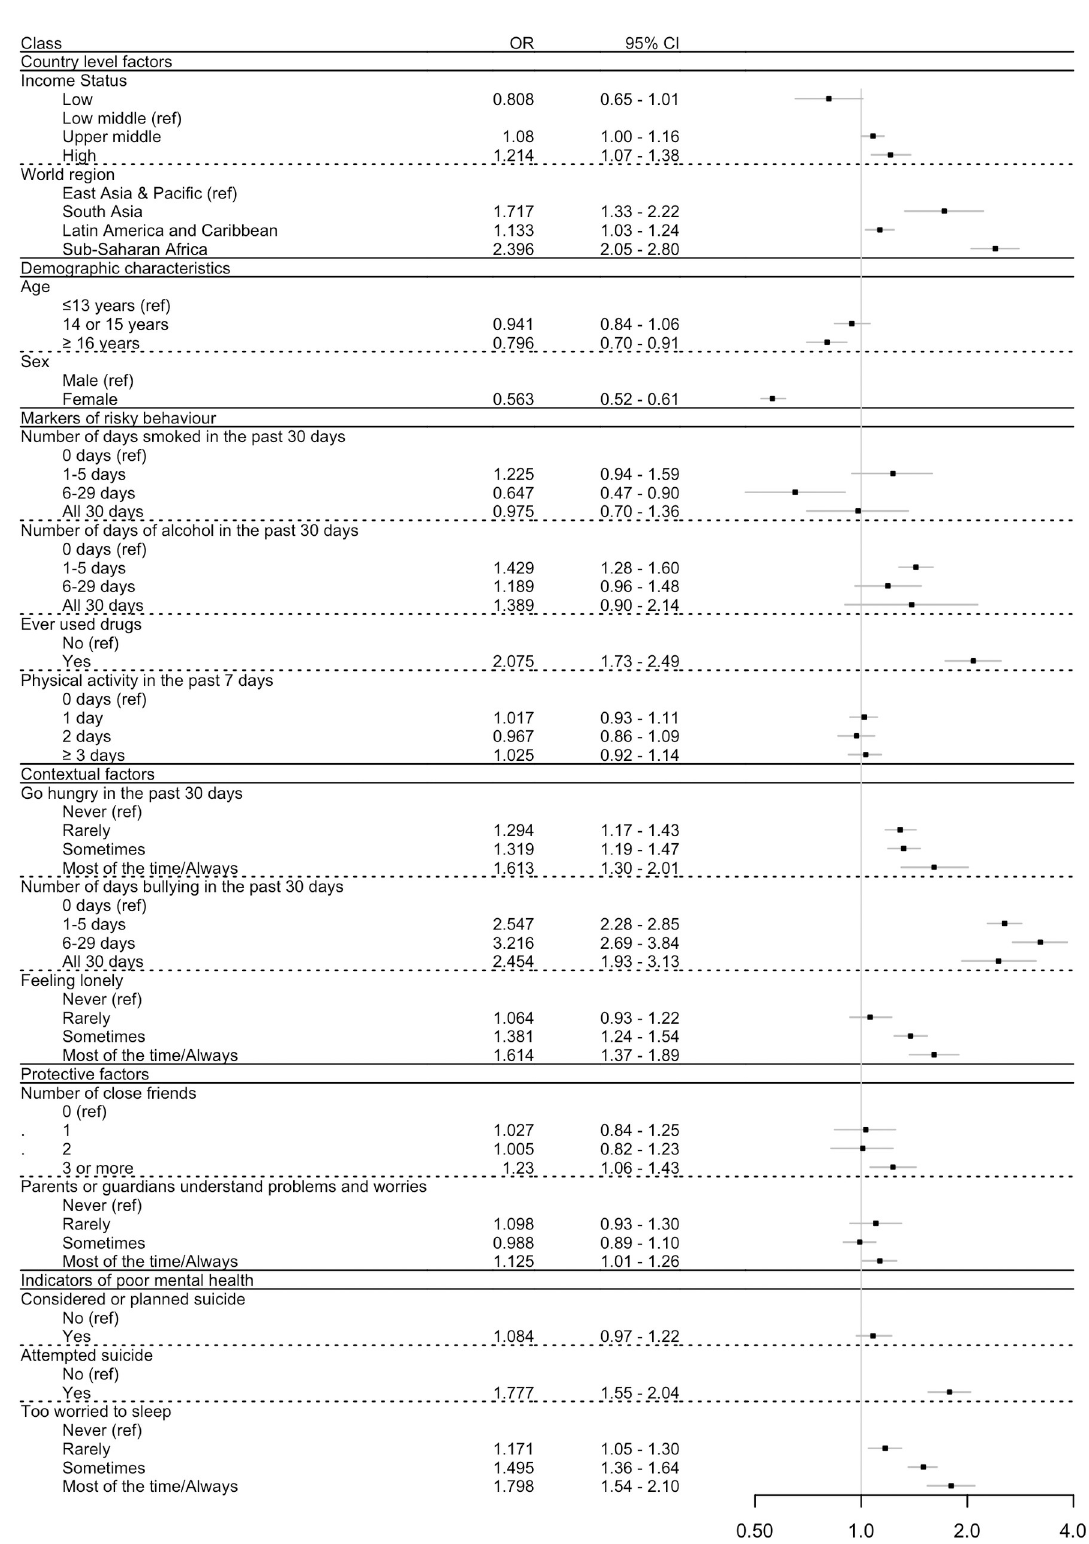
Fig 1. Forest plot showing the multivariable associations (as odds ratio [OR] and 95% confidence interval [95% CI]) between serious injury occurrence and psychosocial circumstances, adjusting for country-level factors and demographic characteristics,